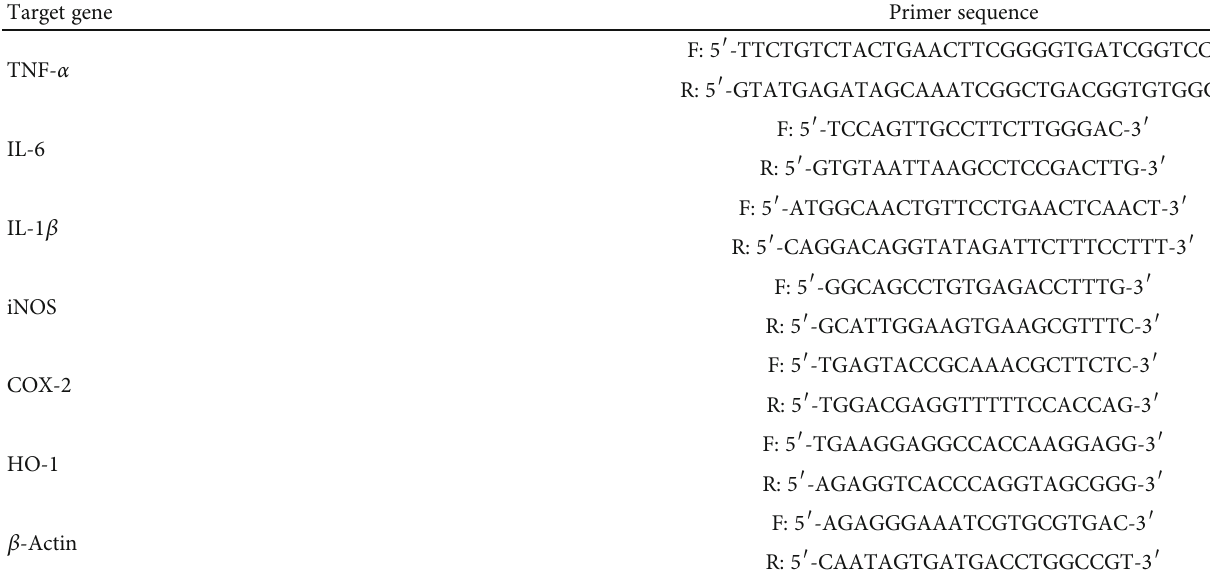
Table 1: Primers used for